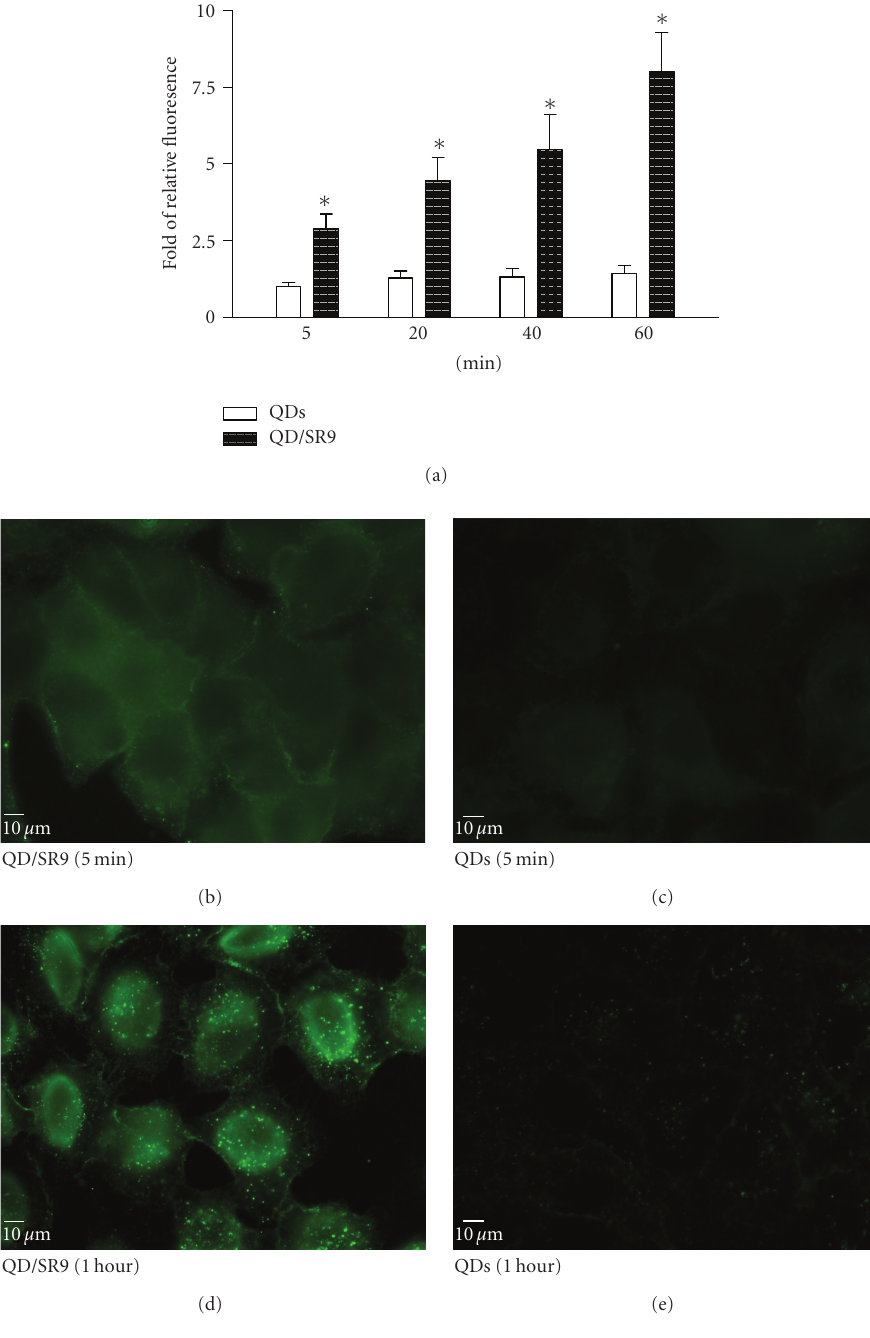
Figure 5: SR9 facilitates QD uptake. (a) The relative QD fluorescence intensity in cells exposed to QD or QD/SR9. A549 cells were treated with 150 nM QDs and 150 nM QD/SR9 (1:20) for 5min, 20min, 40 min, and 60min. Fluorescence intensity is normalized relative to QDs alone at 5min. (b) and (c) QD fluorescence in cells with and without SR9 after a 5-minute exposure. (d) and (e) QD fluorescence in cells with and without SR9 after a 1-hour exposure. Images are from a single plane of Z series. Values are mean ± SD from three independent experiments. Significance is indicated by ∗ P < . 01 versus QDs-alone